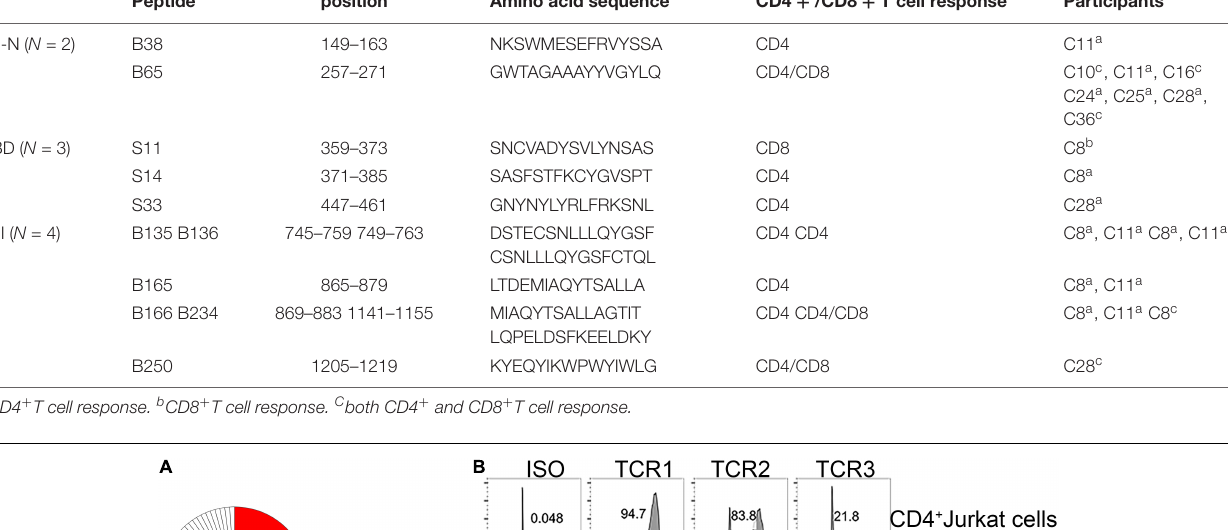
TABLE 1 | Peptides containing T cell epitopes. Peptide Amino acid sequence CD4 + /CD8 + T cell response Participants